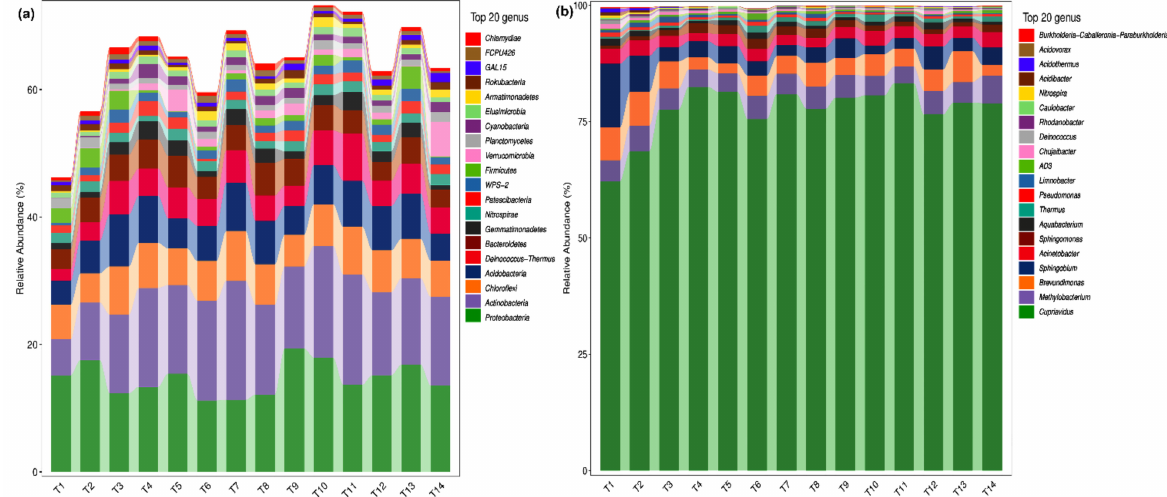
Figure 1. Phylum and genus horizontal species composition in Phoebe bournei seedlings’ soil bacteria under different fertilization treatments (T1–T14). ( a ) Genus horizontal; ( b ) phylum horizontal.